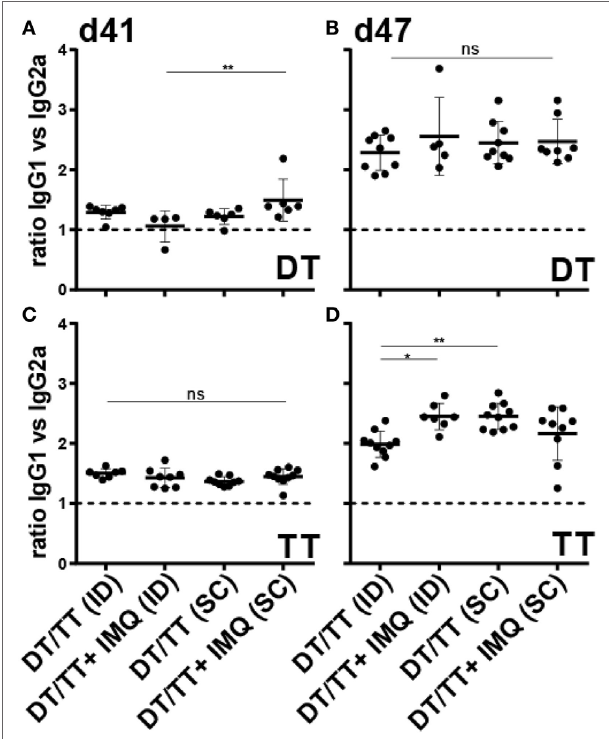
FigUre 6 | Ratio IgG1:IgG2a serum responses after microneedle-based intradermal (ID) and subcutaneous (SC) immunization with diphtheria toxoid (DT) (a,B) and tetanus toxoid (TT) (c,D) after the first boost (a,c) and second boost (B,D) vaccination. When antigens were adjuvanted with imiquimod (IMQ), only half of the antigen dose was applied compared with non-adjuvanted groups. Kruskal–Wallis test with Dunn’s post hoc test was performed to determine statistical differences between